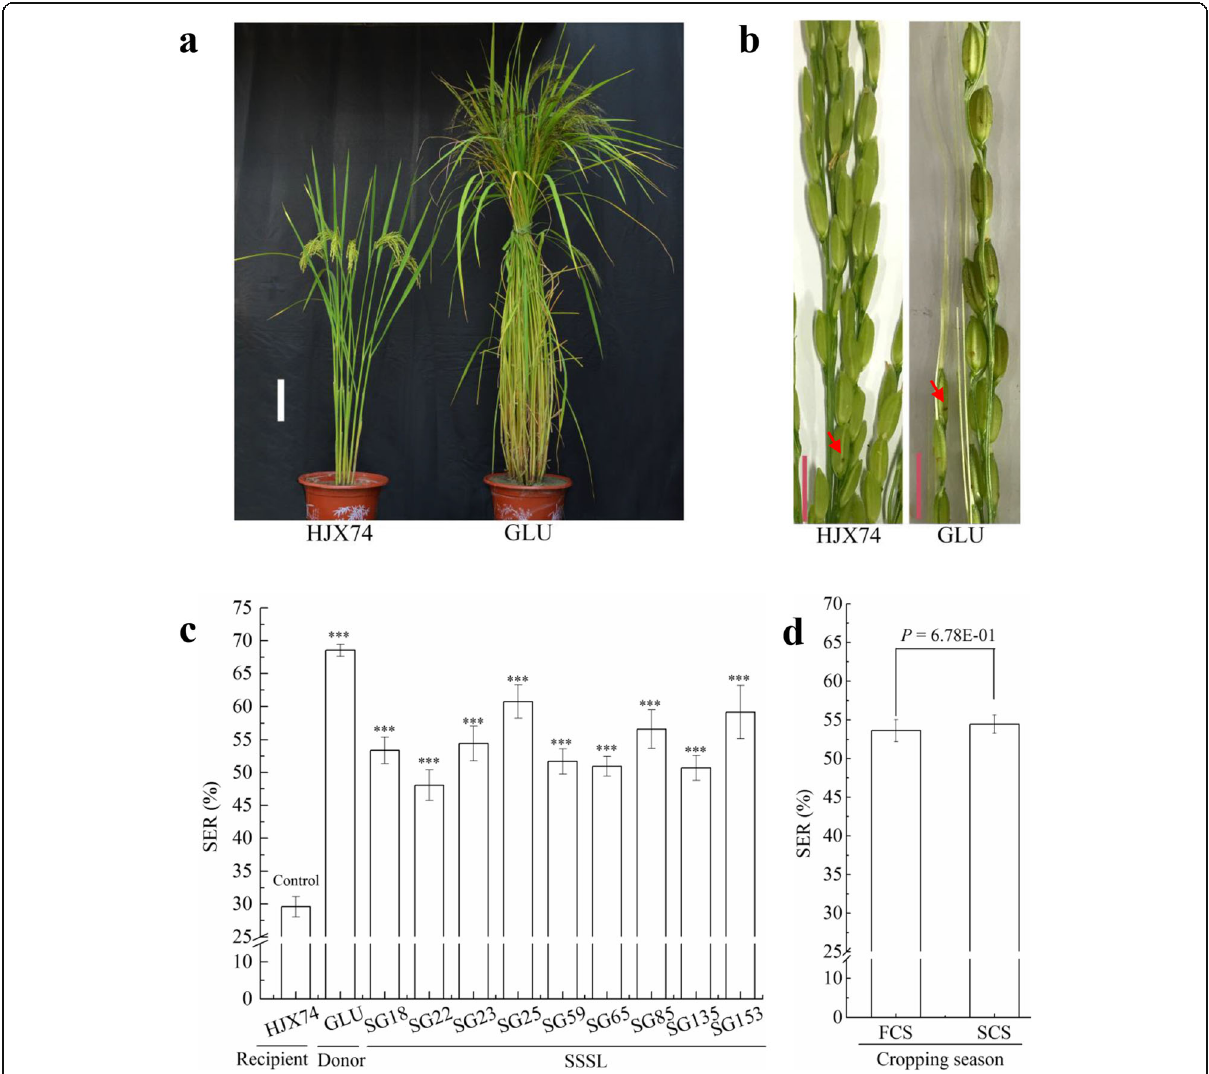
Fig. 1 Stigma exsertion of the SSSLs and their parents. a Plant type of the parents. Scale bar, 15 cm. b Phenotype of exserted stigmas of the parents. The red arrow points to the exserted stigmas. Scale bar, 1 cm. c SER in 9 SSSLs and their parents. Data are presented as mean ± S.E. of five cropping seasons. One-way ANOVA, LSD, two-tailed, *** p -value ≤ 0.001. d Comparison of SER between FCS and SCS. Mean ± S.E., two-tailed, two sample Student ’ s t test. GLU: Oryza glumaepatula . SER: stigma exsertion rate. SSSL: single segment substitution line. FCS: first cropping